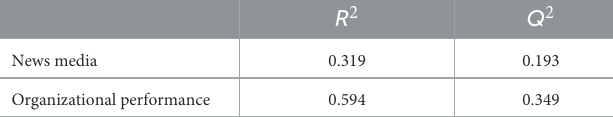
TABLE 6 R-square values and Q-square values for the